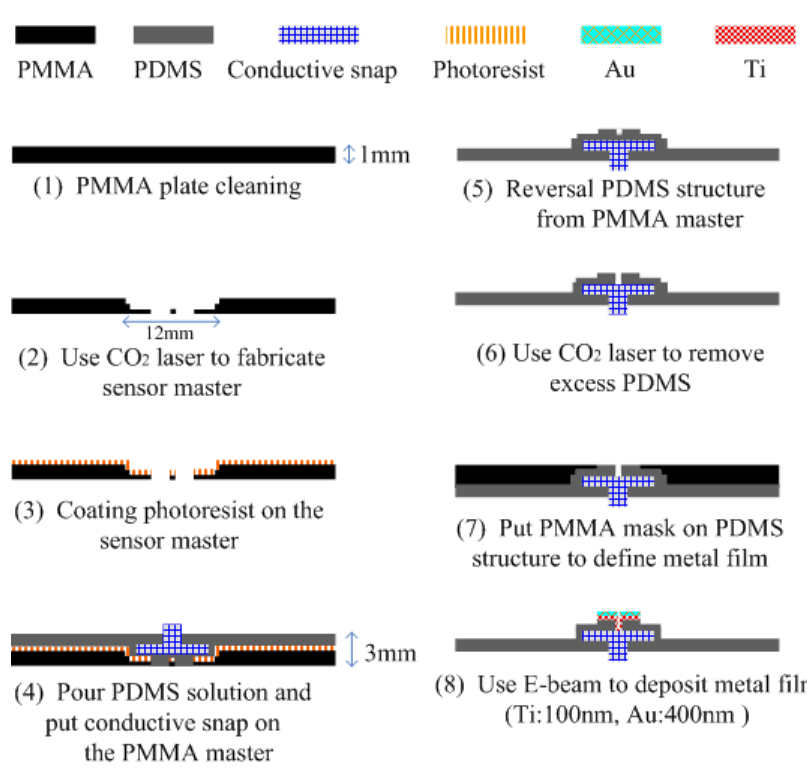
Figure 3. PDMS molding process